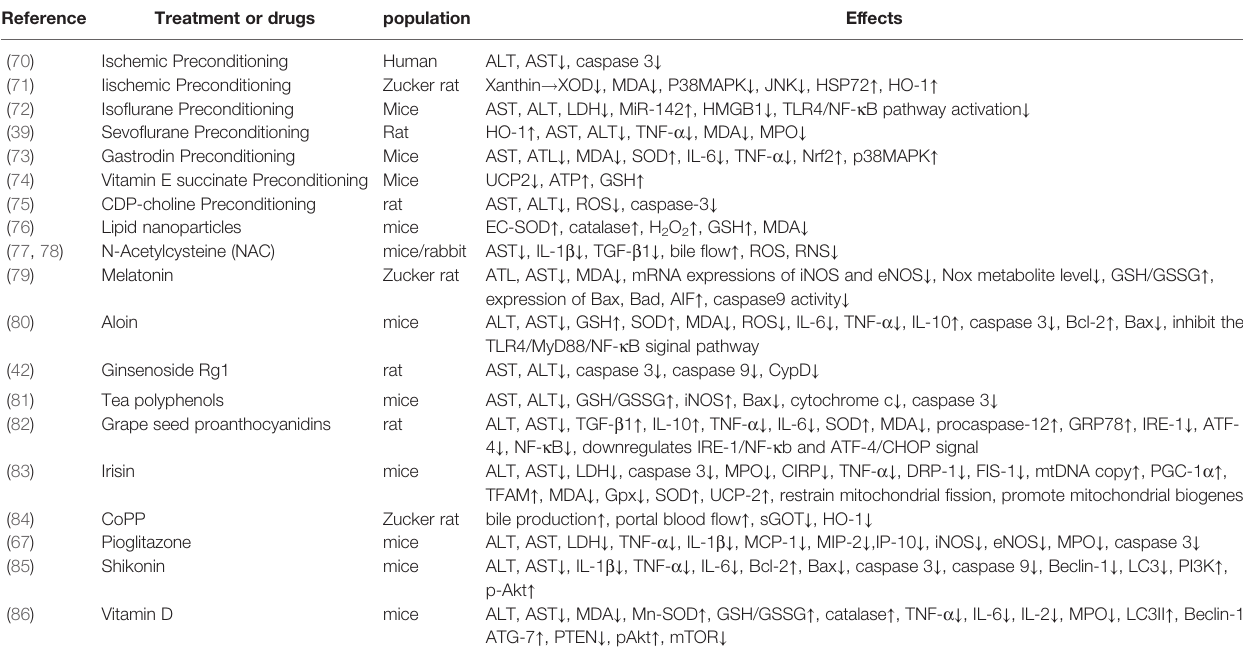
TABLE 1 | Possible treatment or drugs on alleviating IR injury and